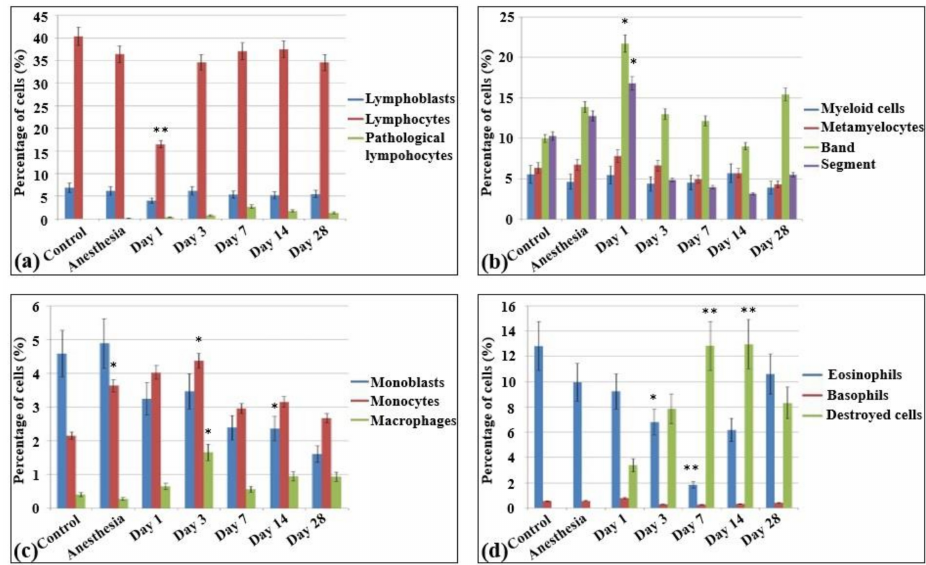
6% of the bone marrow cells displayed signs of apoptosis. The populations of monoblasts and segmented neutrophils did not reach the control levels even on day 28 (Table S2).